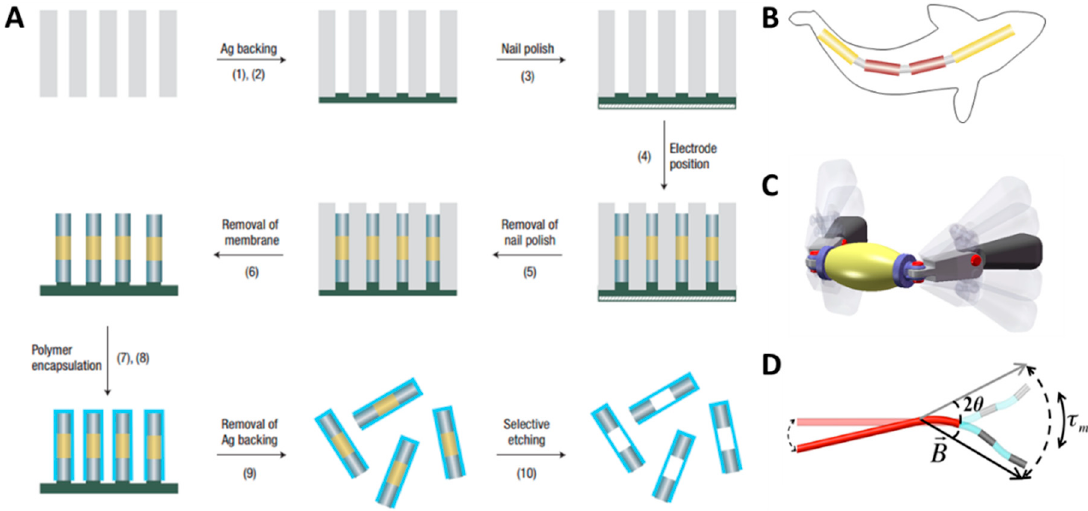
Figure 2. Membrane template-assisted electrodeposition of nanowires. ( A ) Preparation procedure of flexible metallic nanowires with polyelectrolyte hinges after membrane template electrodeposition. Adapted with permission from Reference [103], copyright Nature Nanotechnology 2007. ( B ) Schematic illustration of a fish-like nanoswimmer. Adapted with permission from Reference [84], copyright Small 2016. ( C ) Model of a freestyle magnetic nanoswimmer. Adapted with permission from Reference [83], copyright Nano Letter 2017. ( D ) Schematic representation of a magnetic multilink nanoswimmer. Adapted with permission from Reference [104], copyright Nano Letter 2015.